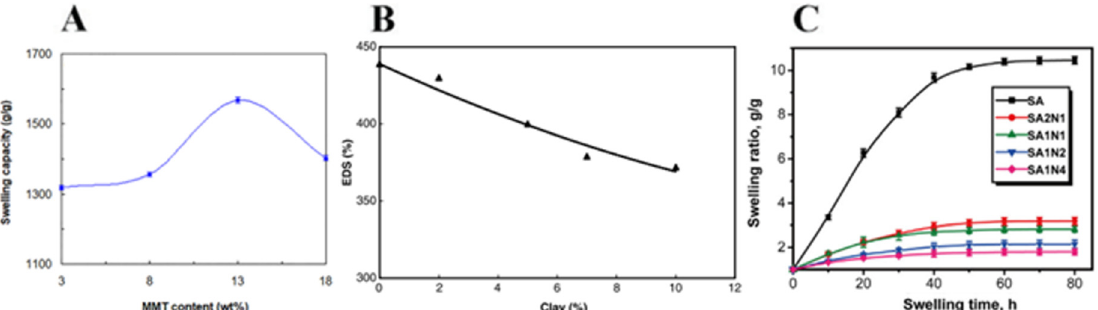
Figure 10 . Nanocomposites’ swelling variation with clay content. ( A ) Swelling capacity of CS-g- poly(AA-co-AAm)/PVP/MMT samples. (Adapted with permission from [58]. Copyright 2019, Advanced Pharmaceutical Bulletin). ( B ) Swelling degree of PVA–MMT hydrogels. (Adapted with permission from [52]. Copyright 2017, Elsevier). ( C ) Swelling ratio of sodium alginate SA and SA/HNTs hydrogels. (Adapted with permission from [60]. Copyright 2017, Elsevier).